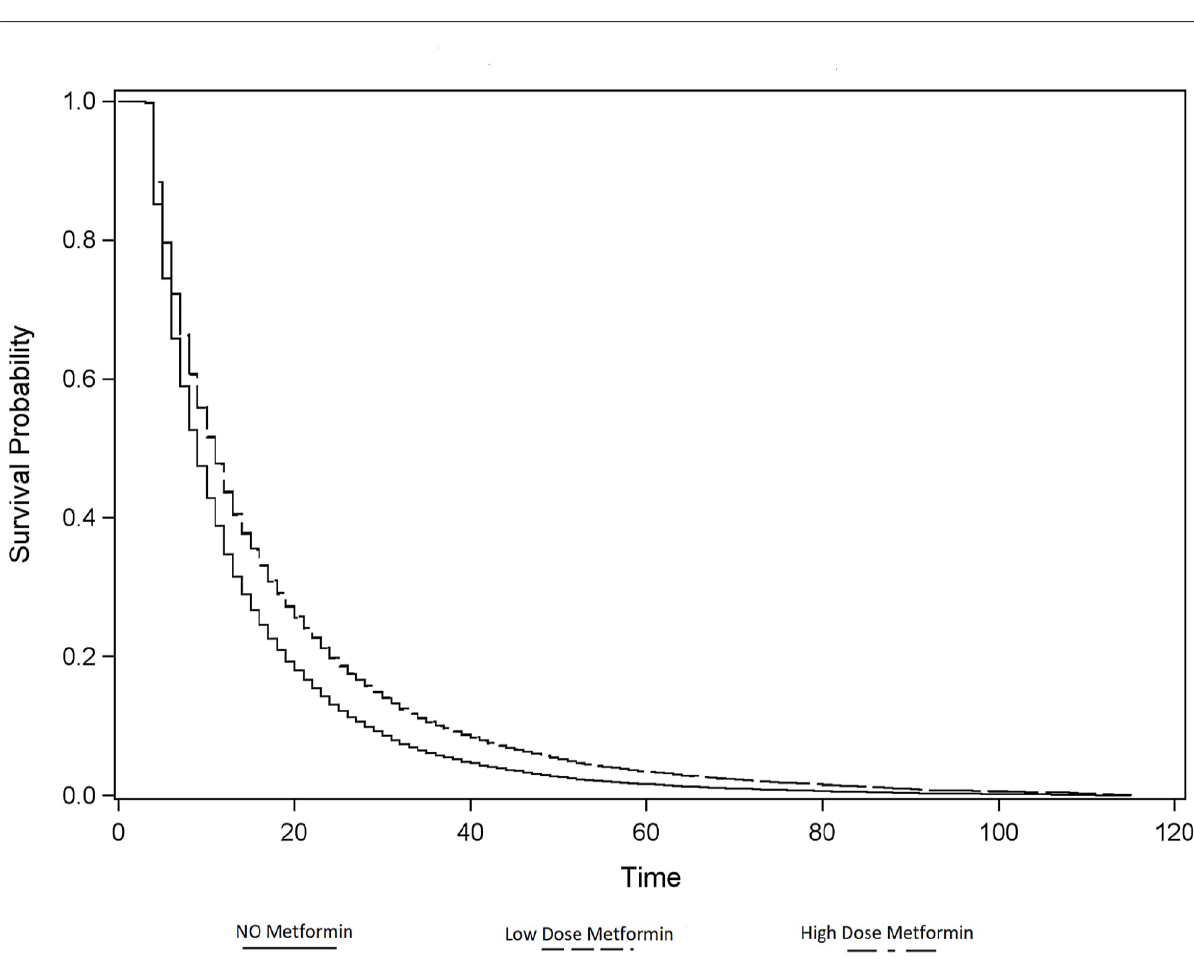
Fig 1. Kaplan-Meier curves of overall survival between patients with Metformin and those without Metformin.